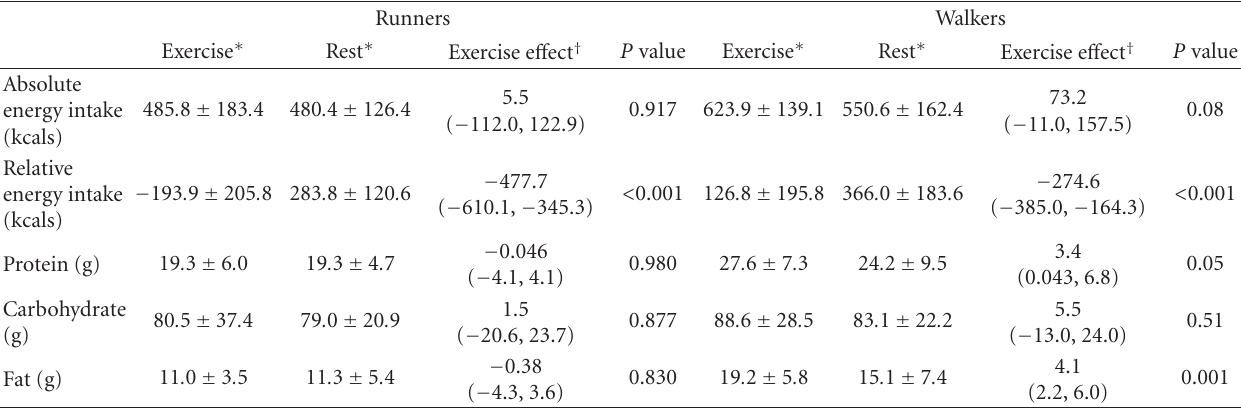
Table 5: E ff ect of exercise on absolute energy, relative energy, and macronutrient intake, among runners and among walkers. Runners